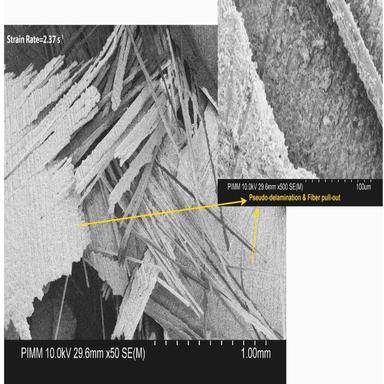
Pseudo-delamination of high strain shear test in RO-A-SMC.